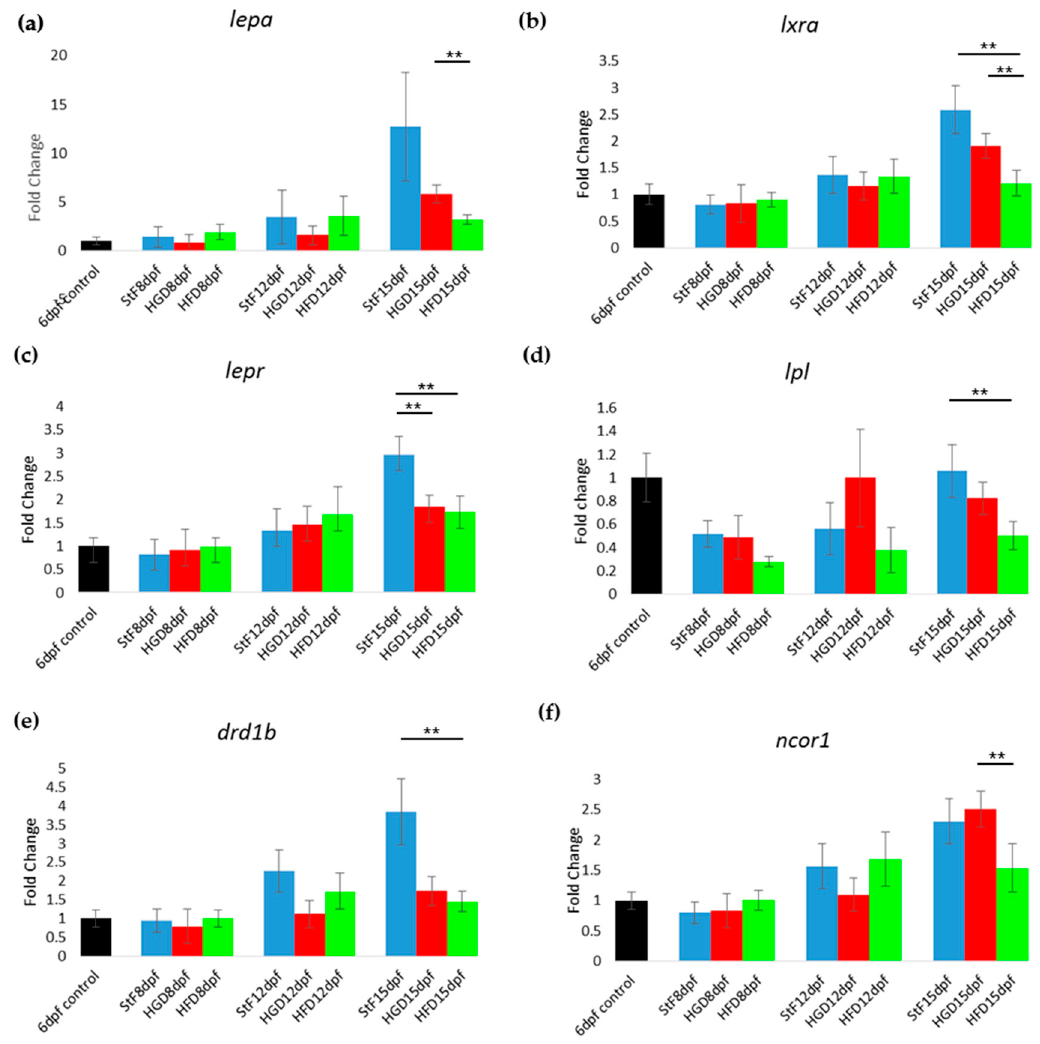
Figure 5. Gene expression of hormones and receptors of the adipose tissue-gut-brain pathway during adipogenesis. ( a – f ) Fold change in expression at 8, 12 and 15 days, relative to mRNA sampled from embryos at 6 days post fertilization prior to the start of feeding (6 dpf control). Larvae were fed with standard diet (StF), high glucose diet (HGD), or high fat diet (HFD). (** p ≤ 0.05). ( n = 4 (each sample contained 10 larvae)). Error bars represent SEM.